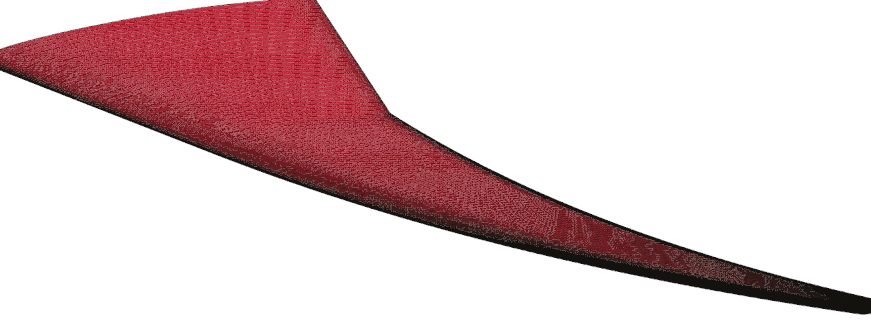
Figure 4: Curved-wing surface mesh.